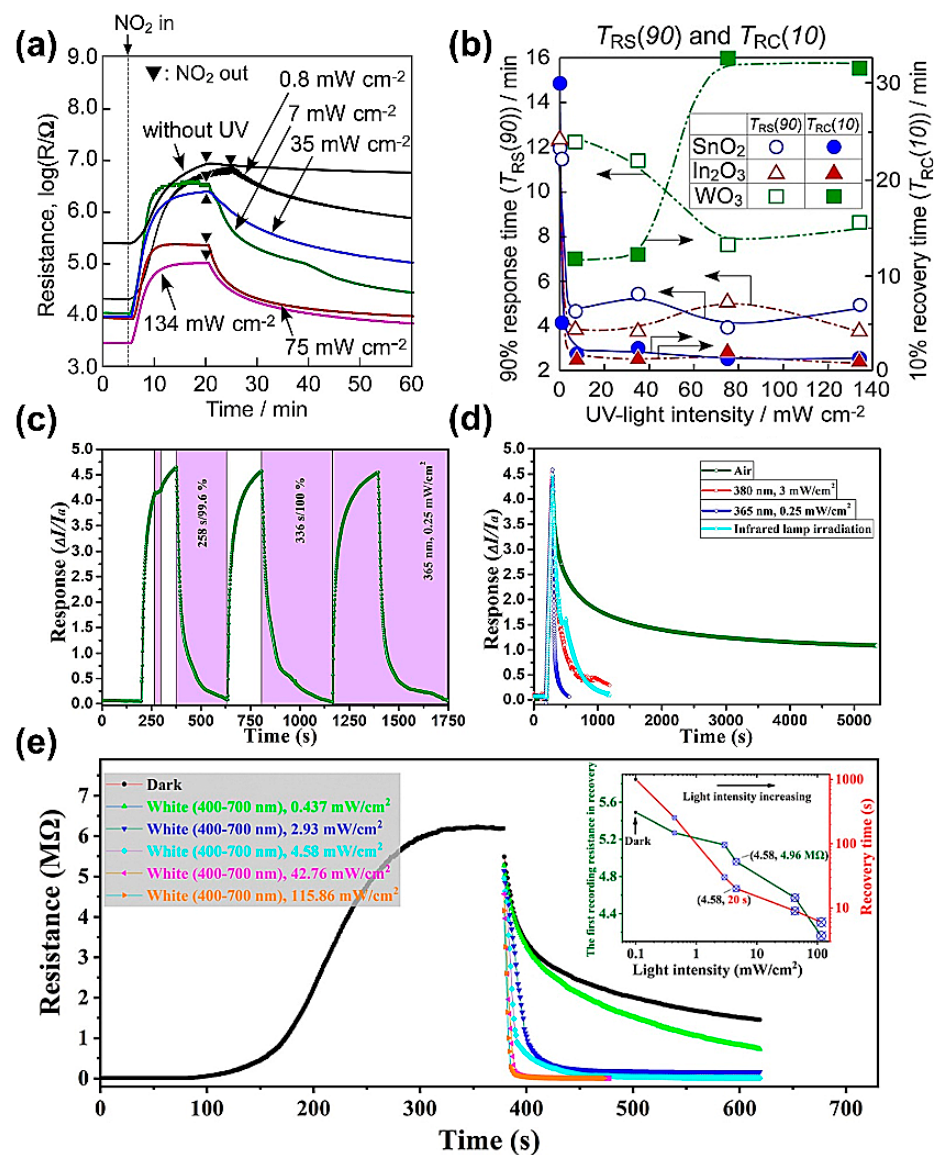
Figure 6. ( a ) Response transients of SnO 2 sensor to 5 ppm NO 2 at 30 °C in dry air under different UV-light irradiation intensities. ( b ) 90% response (T RS (90), open symbols) and 10% recovery times (T RC (10), filled symbols) of SnO 2 sensor with UV-light intensity, together with those of In 2 O 3 and WO 3 sensors. Reprinted with permission from Ref. [69]. Copyright 2017, Elsevier. ( c ) Response and recovery curves of rGO-CeO 2 sensor to 10 ppm NO 2 with or without 365 nm UV-light irradiation and ( d ) comparison of different recovery methods. Reprinted with permission from Ref. [70]. Cop- yright 2018, Elsevier. ( e ) The response (communally) and recovery curves toward 5 ppm NO 2 at room temperature of the In 2 O 3 sensor in dark or under visible light irradiation with increasing in- tensity. The illustration displayed the variation trend of the recovery time and the first recording resistance in recovery with increasing light intensity. In the illustration, a larger blue symbol repre- sents a stronger light. Reprinted with permission from Ref. [71]. Copyright 2021, Elsevier.